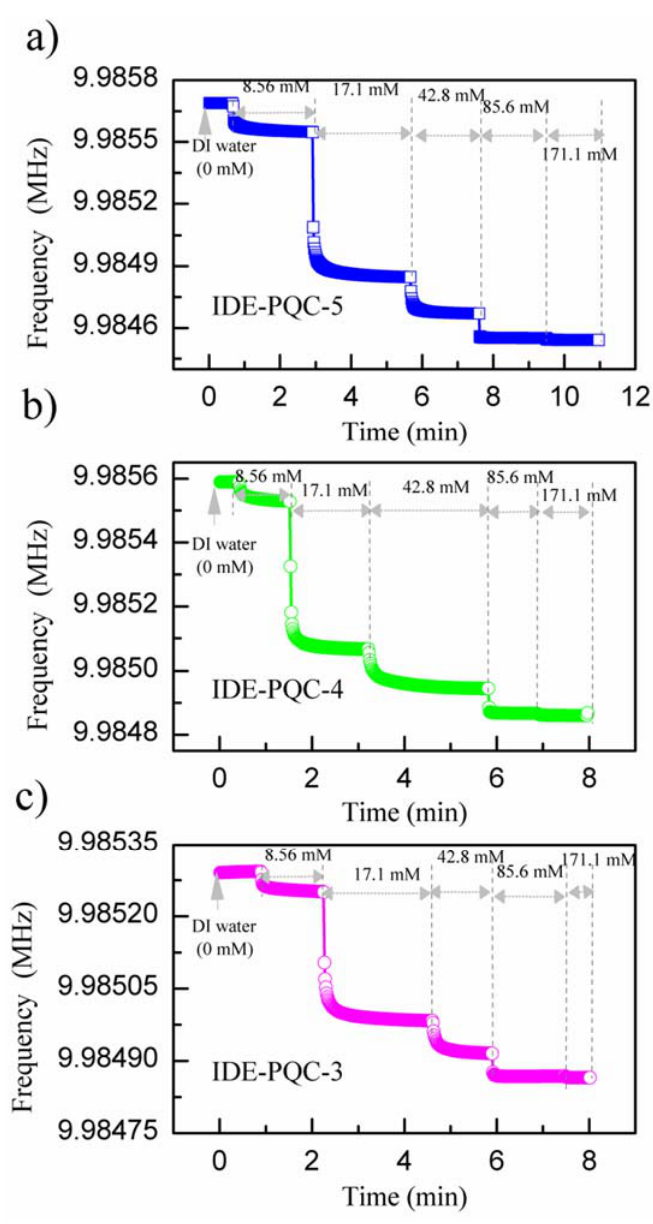
Figure 9. Transient response of IDE-PQC sensor to different NaCl solution concentrations.